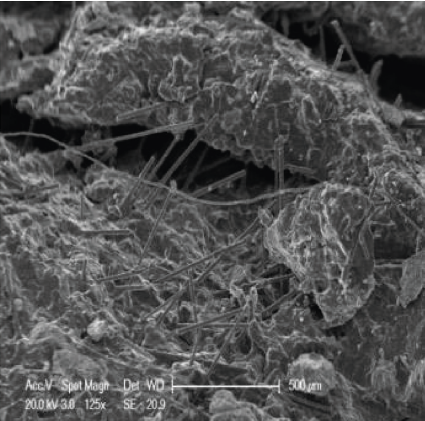
Figure 17: SEM micrographs of the crack of the porous asphalt mixture.